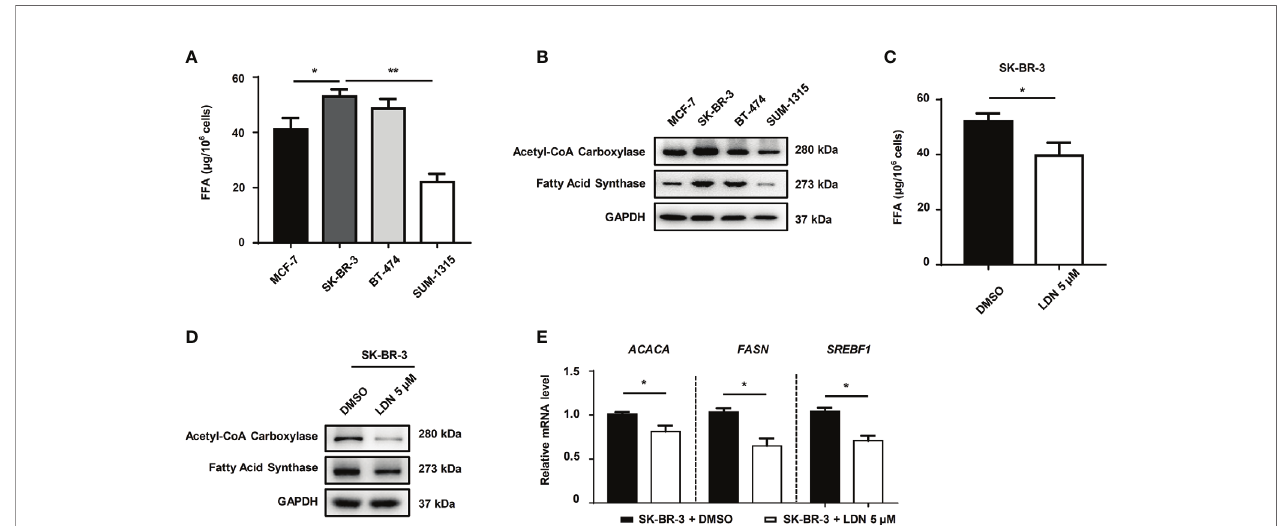
FIGURE 4 | The role of UCHL1 in fatty acid synthesis in BC cells. The level of fatty acids in different subtype BC cells (A) and SK-BR-3 cells in the presence of 5 m M LDN or DMSO (C) . Western blot (B, D) and real-time PCR (E) analysis of lipogenesis-associated proteins in BC cells are shown and were analyzed by Mann – Whitney test (n = 3). * p < 0.05, ** p < 0.01.